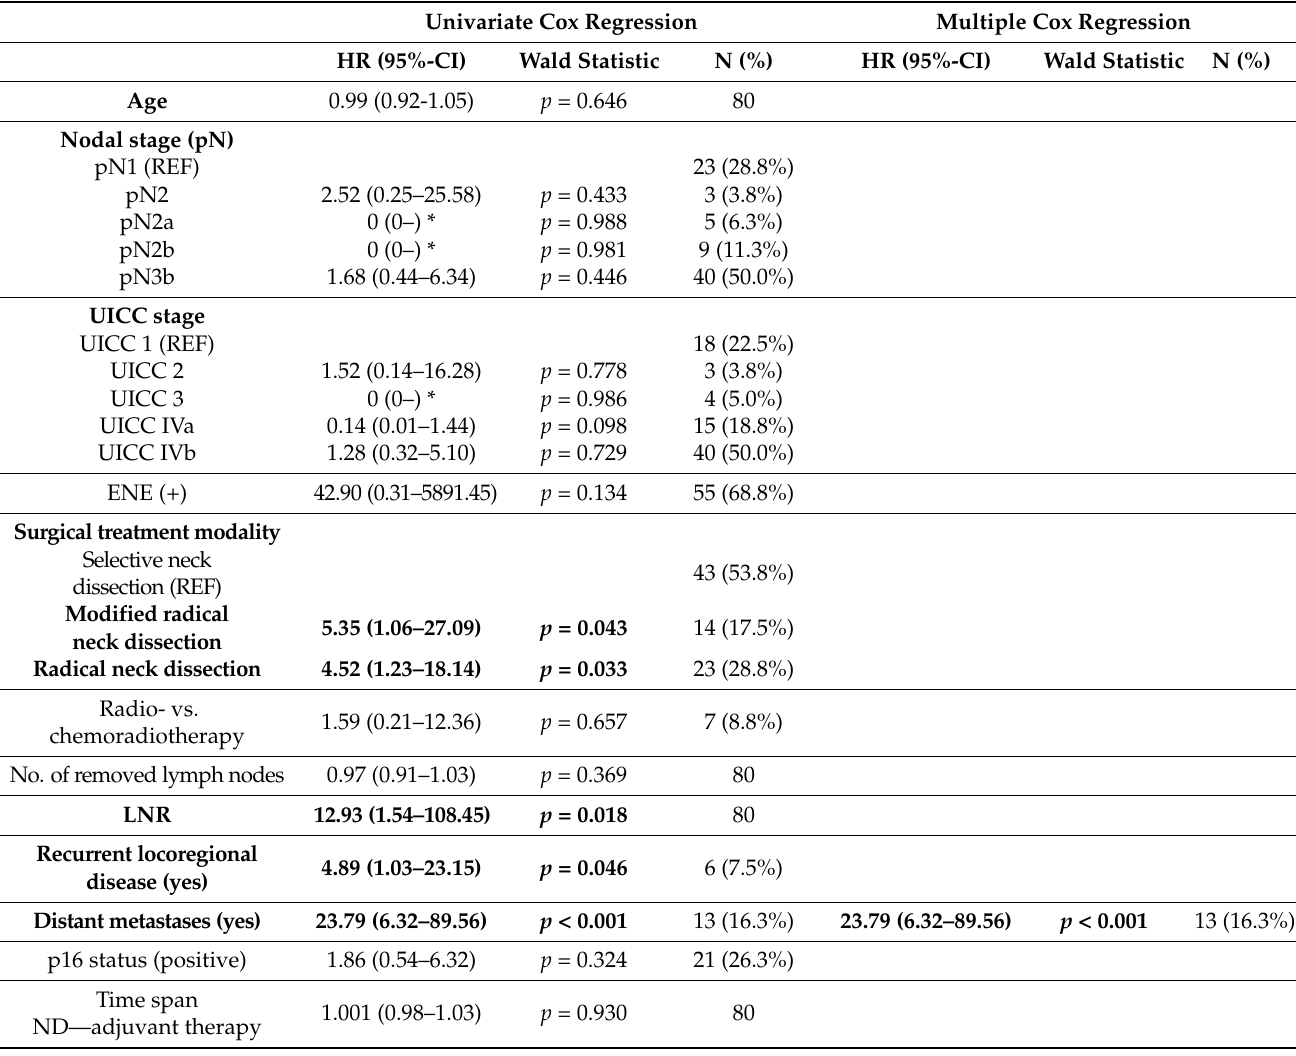
Table 5. Univariate and multiple Cox regression for DSS.